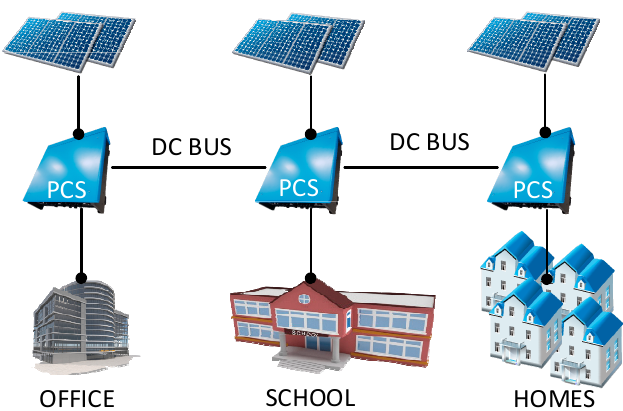
Figure 4. Multi-point DC microgrid configuration.